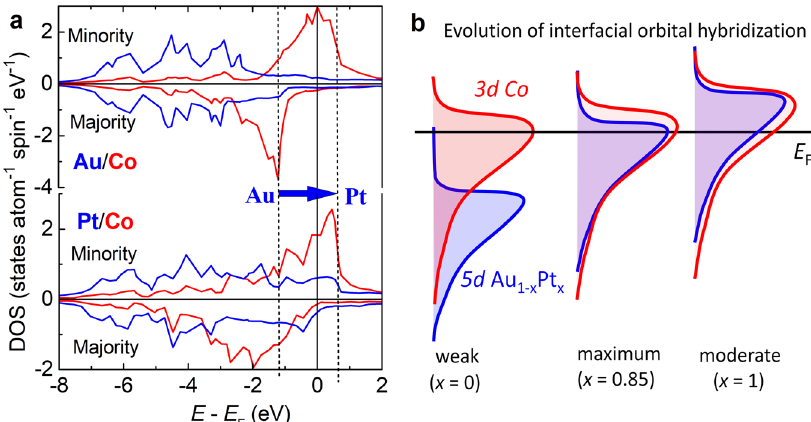
Fig. 3 Critical role of interfacial orbital hybridization. a Calculated local density of states (DOS) for Au/Co (up) and Pt/Co (down) interfaces (blue for the DOS of Au and Pt, red for that of Co) 51 , highlighting a substantial shift of the 5 d (3 d ) band from below (around) to beyond the Fermi level ( E F ) as a function of x . The two dashed lines refer to the top of the 5 d bands of Au and Pt. Note that the Co 3 d states and the Au 1 − x Pt x 5 d states are the main sources of the total DOS of conduction bands around E F . b Schematic depict of the evolution of interfacial orbital hybridization at the Au 1 − x Pt x /Co interface with the composition. At x = 0 (i.e., Au/Co), the 5 d band of Au 1 − x Pt x (blue) has little orbital hybridization with the 3 d minority band of the Co (red) at the E F such that the Dzyaloshinskii-Moriya interaction is the weakest. With increasing x , both bands are increasingly shifted upwards, with the 5 d band is shifted faster than the 3 d band. As a result, the 3 d -5 d orbital hybridization increases gradually and reaches the maximum at an intermediate composition of x = 0.85. As x further increases to 1 (Pt/Co), the peaks of both the 3 d and 5 d bands are shifted far above E E F , resulting in a moderate orbital hybridization at F and a reduced Dzyaloshinskii-Moriya